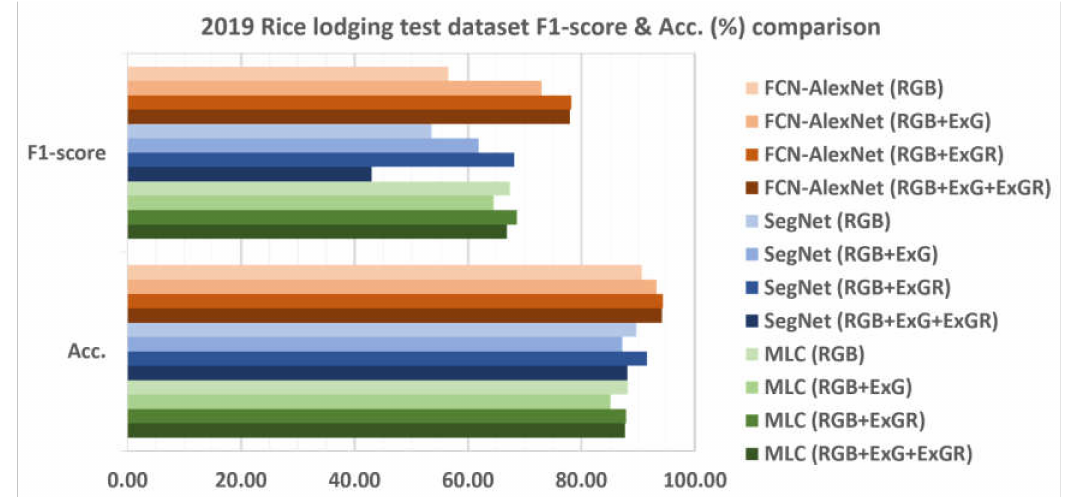
Figure 11. F1-score and accuracy comparison on the 2019 testing dataset for rice